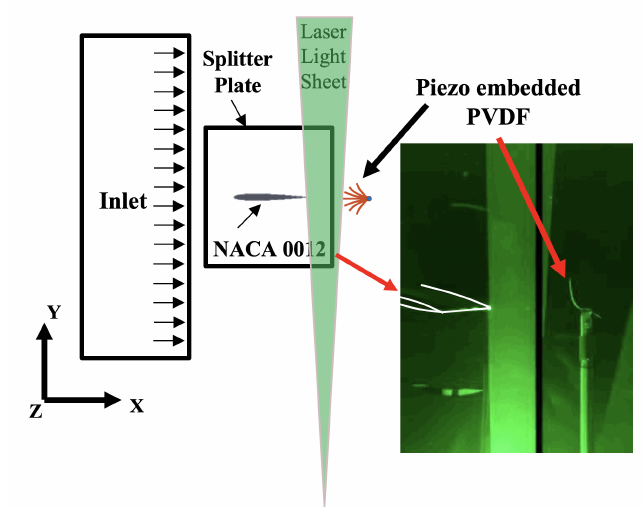
Figure 12. Schematic and picture of the PIV test setup at UD-LSWT in the wake of NACA 0012 with and without piezo embedded